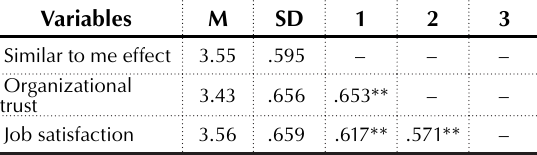
Table 2. Summary of correlations, means and